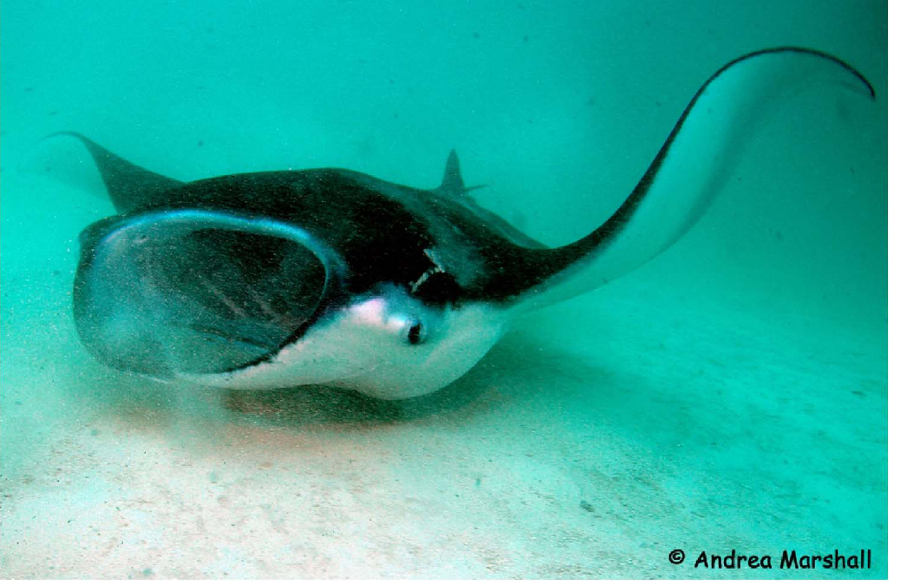
Figure 5. Reef manta ray feeding close to the sea bottom. This is occasionally observed during the day and proposed to be more common at